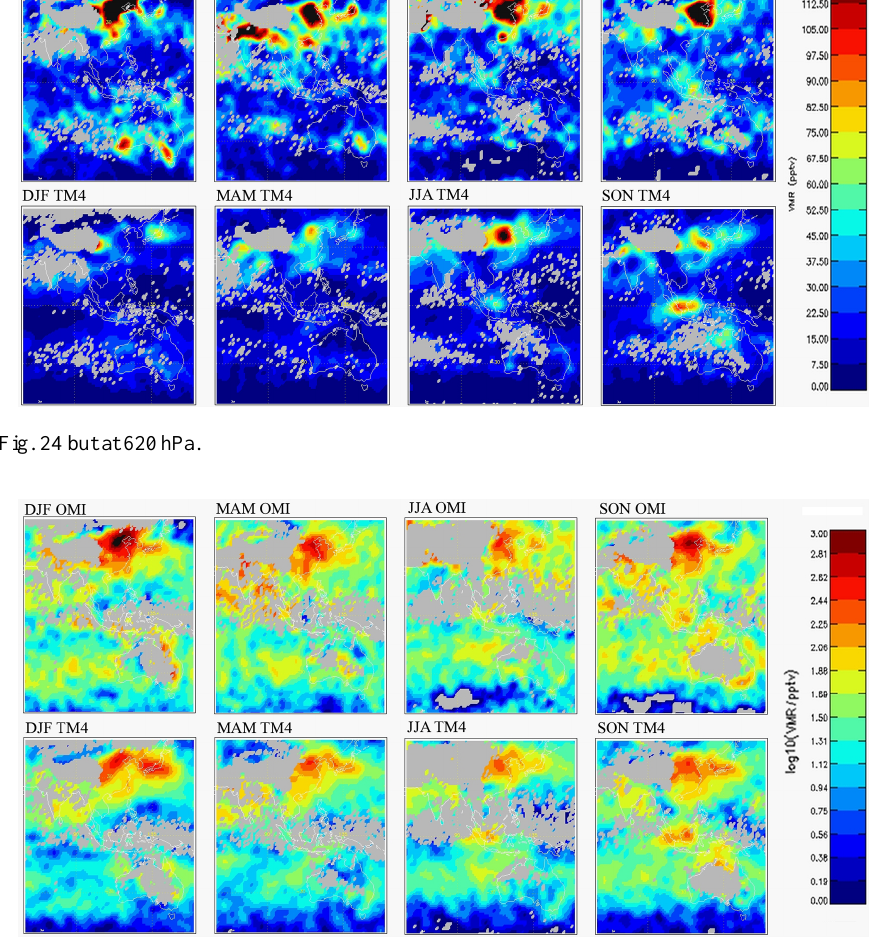
Figure 28. Same as Fig. 24 but at 720hPa in logarithmic